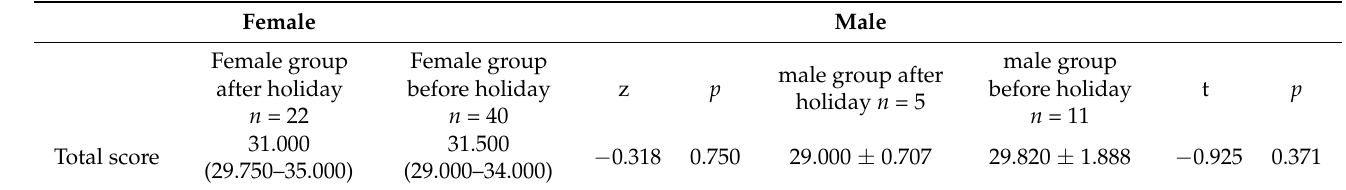
Table 6. Gender stratification in the increased pressure group before and after the holiday.